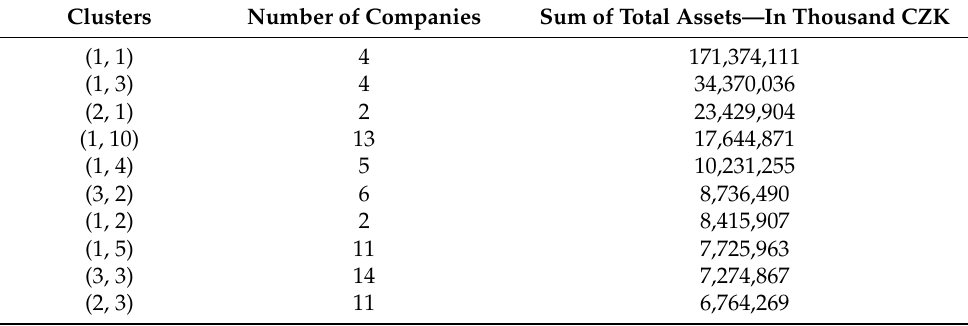
Table 9. Table of ten clusters with the highest sum of assets for the year 2016. Clusters